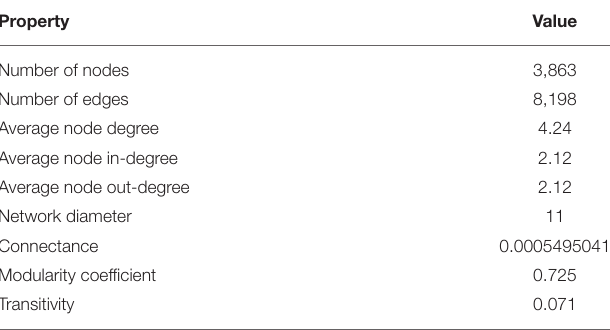
TABLE 1 | Summary metrics of citation network.